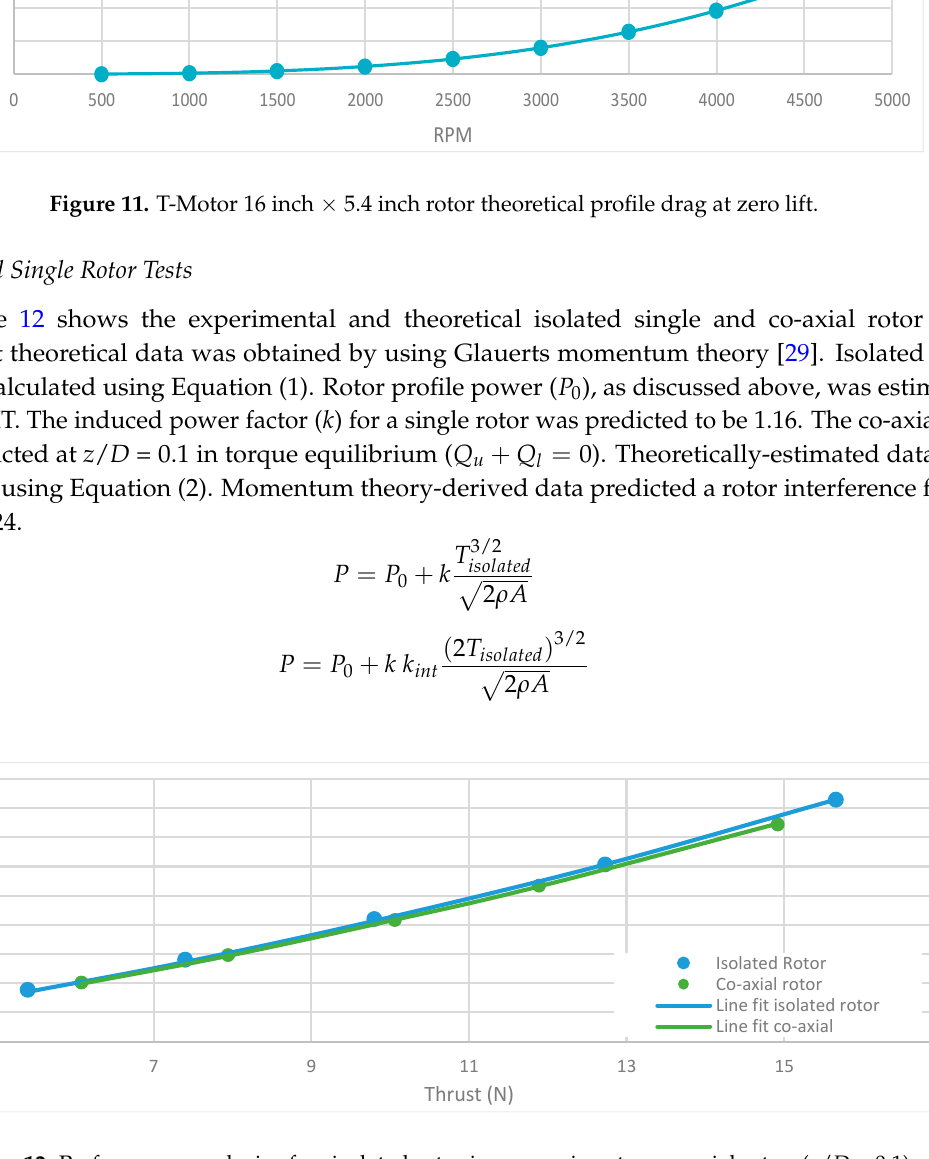
( b ) Figure 10. Test rig arm profile drag. ( a ) Arm profile drag as a function of rotor axial separation z ; ( b ) test rig arm profile geometry (in mm). RTS-100 (Transducer Techniques, Temecula, CA, USA) reaction torque sensors were mounted underneath each motor/rotor assembly (Figure 8a). The sensor data-gathering and test rig control is achieved using National Instruments and Phidgets modules (listed in Figure 9). The test rig was programmed and controlled using Labview 2015 (National Instruments, Newbury, Berkshire, UK). The measurements were aquired at 2 kHz from all of the load cells simultaniously. A maximum of 7000 RPM was used in any test, which gives a minimum resolution of 4.2° when a 5 s data sample is taken. Initial tests revealed close to 2% scatter in the measured torque and thrust. Both rotors were initially individually tested on both arms to obtain a grasp on any asymmetry in the data, since the configuration of the test rig has arms on opposite sides of the rotors. Test results showed that performance difference between both tested arm locations is negligible. The same results have been found by McAlister et al. [16] and Ramasamy [15]. 5. Results The tests conducted on overlapping rotor propulsion systems were split into three main categories: •